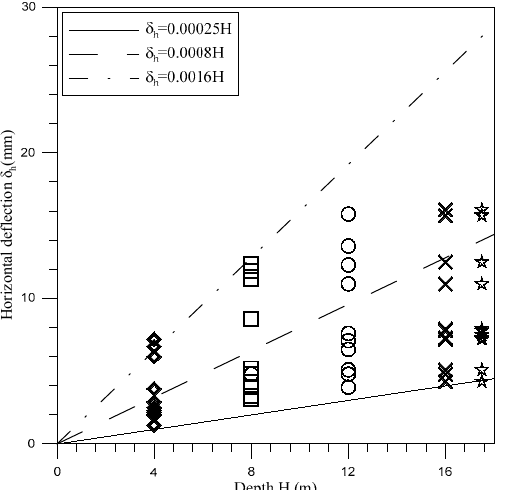
Figure 17. Deflection of retaining wall versus excavation depth (nodes 0–11).